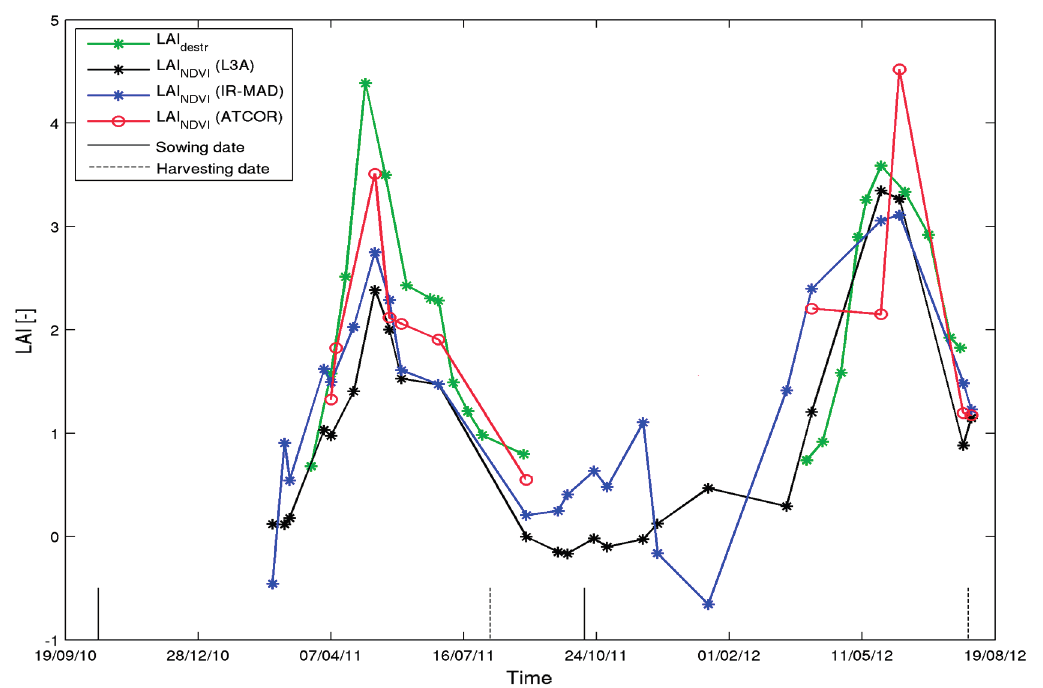
Figure 5. Temporal sequence of field-average destructive LAI destr with remote sensing based LAI NDVI (RapidEye L3A imagery, IR-MAD and ATCOR processed) at Selhausen winter wheat field for 2011–2012.